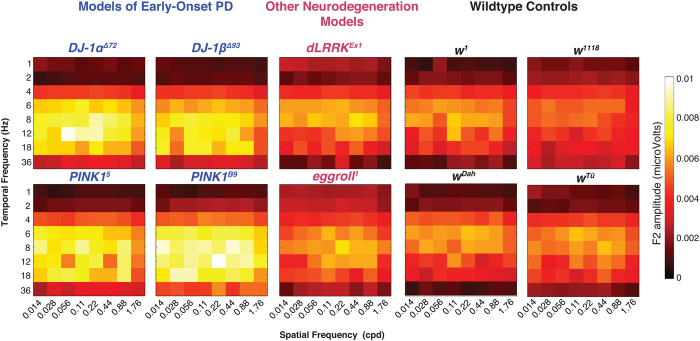
Early-onset Parkinson’s mutations elevate response across a range of spatiotemporal frequencies.Two-dimensional spatiotemporal profiles of all genotypes tested reveal distinct differences between wildtype and PD genotypes, as well as within each genotype. Mutations associated with early-onset Parkinson’s (DJ-1αΔ72, DJ-1βΔ93, PINK15 and PINK1B9) show elevated response amplitudes at distinct regions of the spatiotemporal profile. Other mutations associated with neurodegeneration (dLrrkEx1, eggroll1) show no elevation in response.